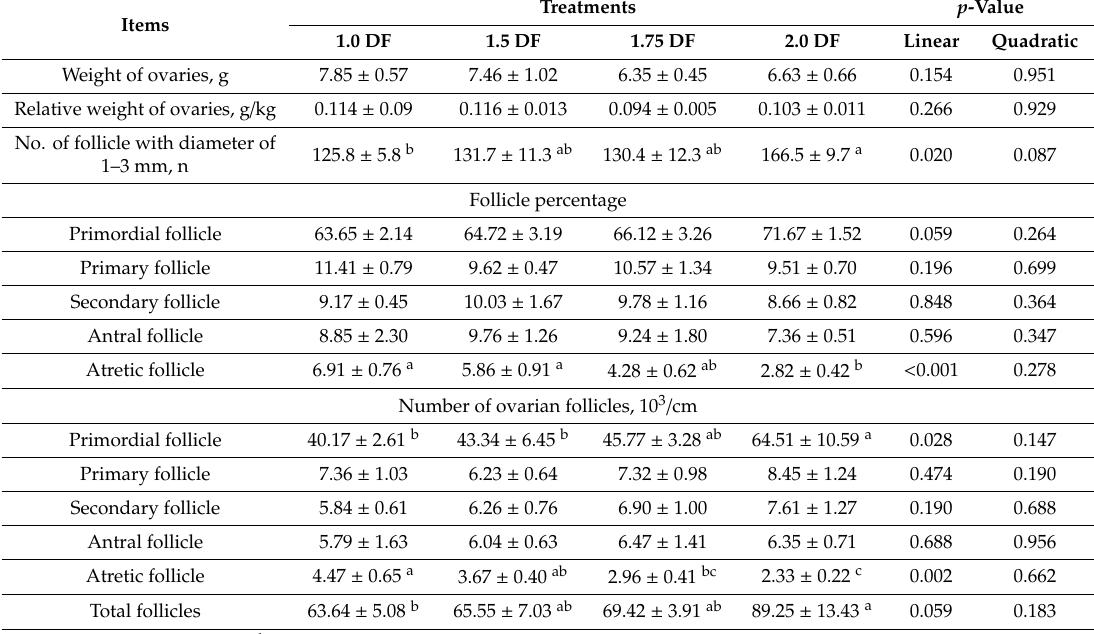
Table 5. E ff ects of dietary fiber levels on development of follicles in gilts at day 30 of the